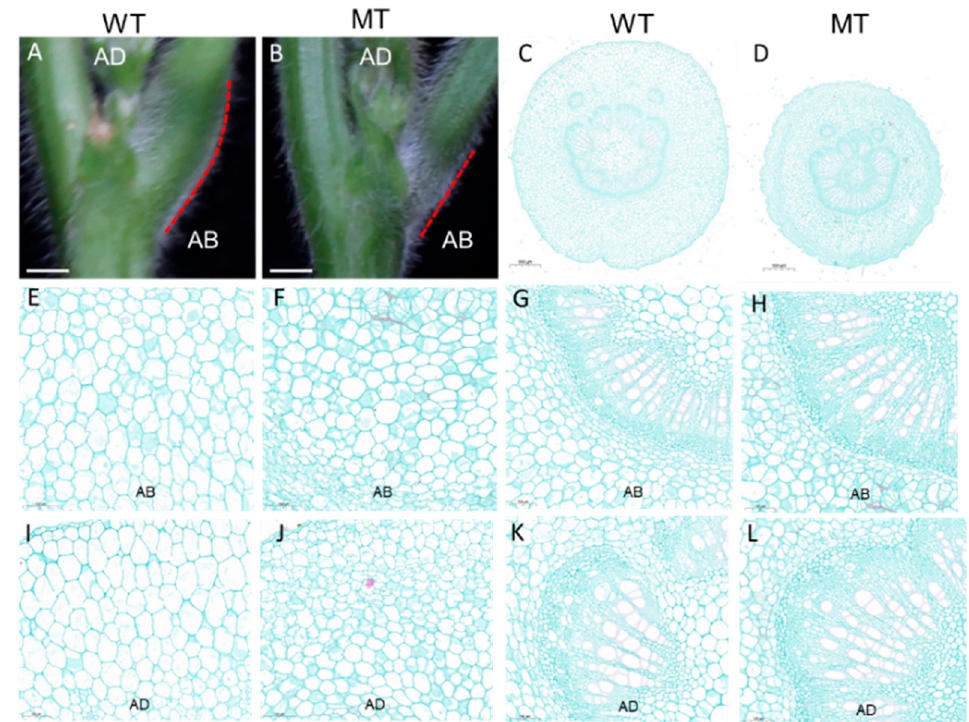
Figure 2. Cross-sectional microstructure of pulvini in wild-type (WT) and spwp mutant-type (MT) plants. A and B: Phenotypic characterization of pulvini in WT ( A ) and MT ( B ) plants, respectively. The scale bars are 1 cm. ( C , D ): Transection of pulvini in the WT ( C ) and MT ( D ), respectively. The scale bars are 500 µ m. ( E – L ): Partial magnifying views of the transection of pulvini in the WT ( E , G , I , K ) and MT ( F , H , J , L ). The scale bars are 100 µ m. ( E , F ) indicate the motor cells of the WT and MT on the abaxial side (AB), respectively. ( I , J ) indicate the motor cells of the WT and MT on the adaxial side (AD), respectively. ( G , H ) indicate the vascular cylinder of the WT and MT on the abaxial side, respectively. ( K , L ) indicate the vascular cylinder of the WT and MT on the adaxial side, respectively.